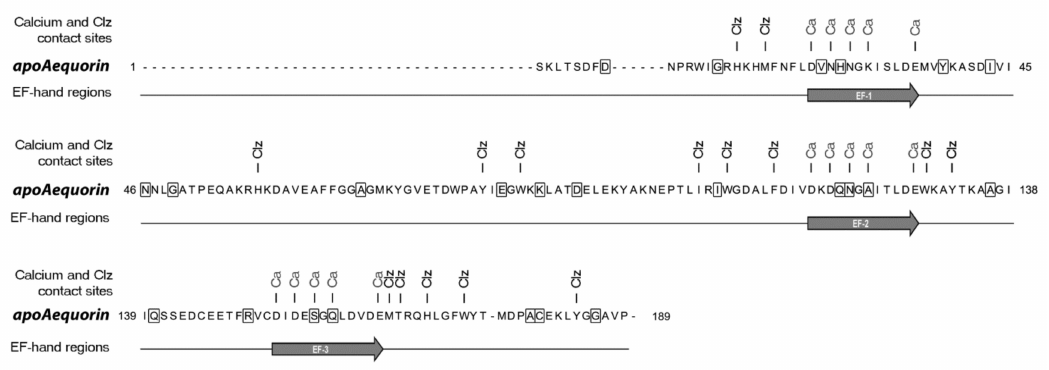
Figure 1. Apoaequorin amino acid sequence highlighting the mutated sites screened for enhanced Ca 2 +